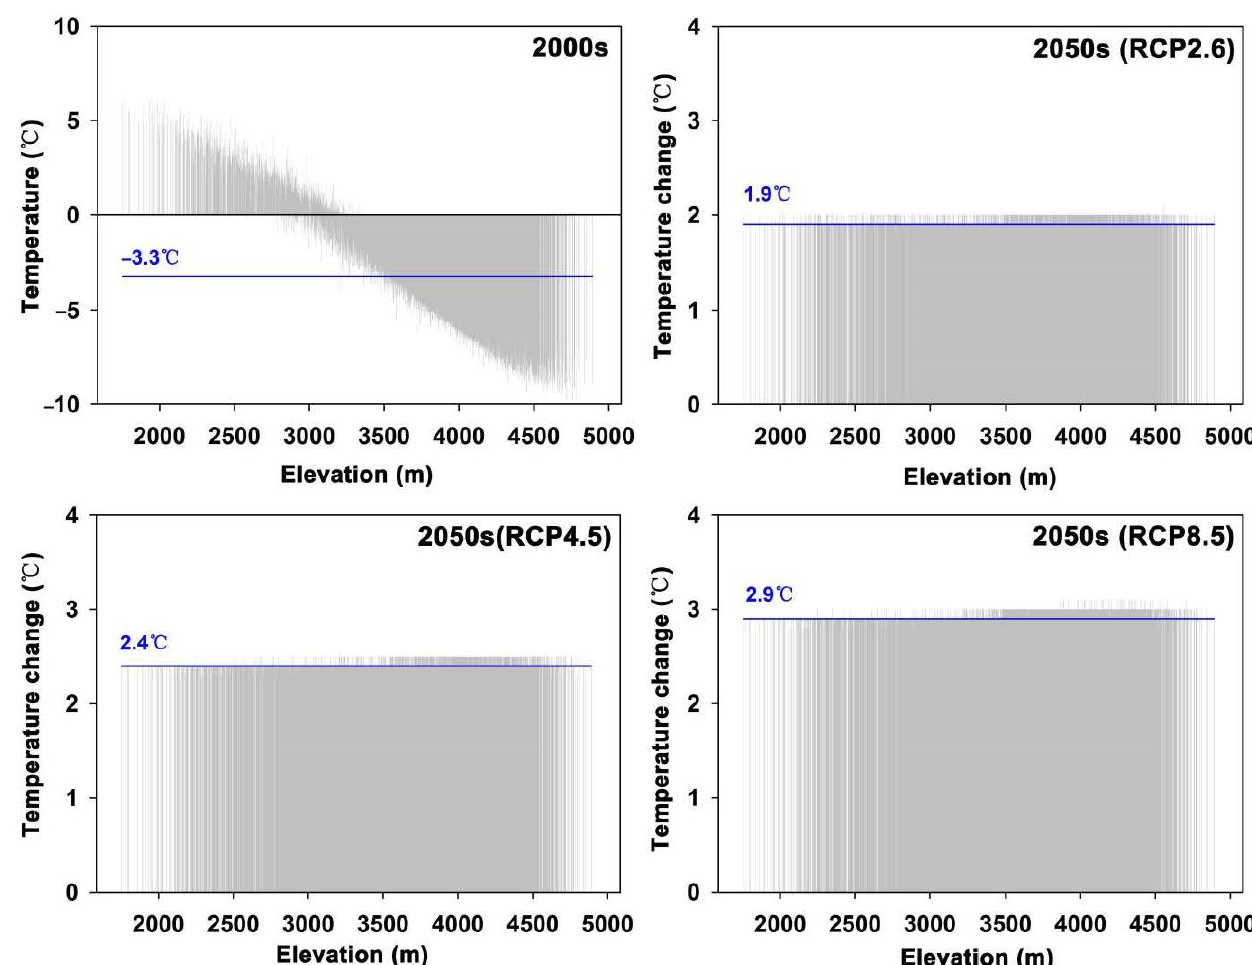
Figure 4. Variation of mean annual temperature in the 2000s, and temperature change (difference for temperature between the 2050s and the 2000s) under the RCP2.6, RCP4.5, and RCP8.5 scenarios, along the elevation gradient for each 1 km × 1 km pixel. Note: The blue lines indicate the area-weighted averages of temperature or temperature difference between the 2050s and the 2000s for the whole study area. Each vertical gray line represents a 1 km × 1 km pixel over the study area, and the height of the gray line indicates the temperature value at that pixel. Most parts of the study area were located in regions with elevations ranging from 3000 to 3800 m, and thus, gray lines are much denser in mid-elevation zones, while sparser in high- and low-elevation